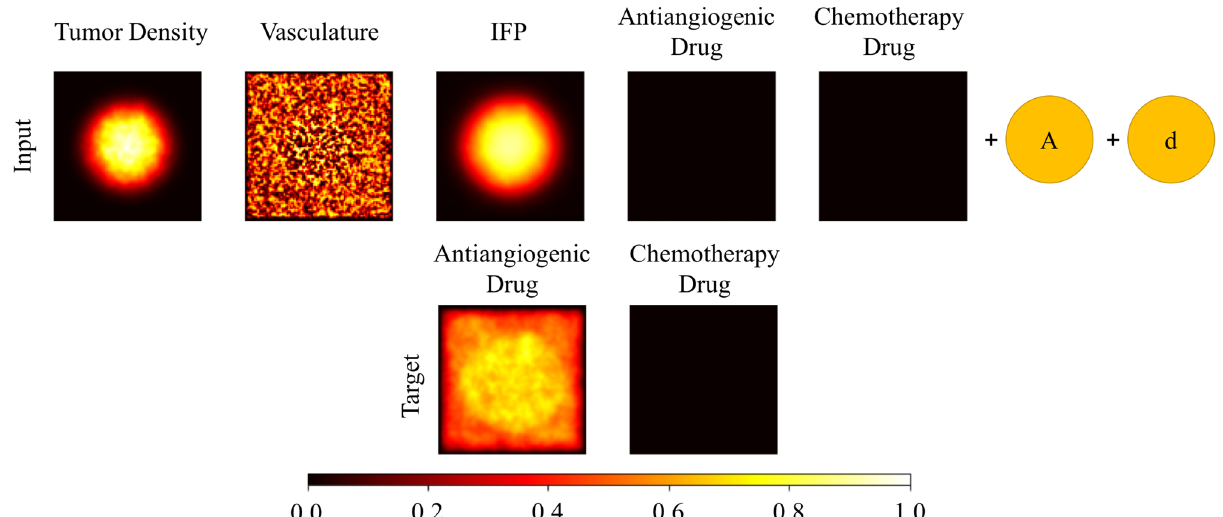
Figure 4. An example pair from the Diffuser dataset is shown. The input and target tensors are presented in first and second rows respectively. The input tensor consists of five channels which are tumor density, vasculature, IFP, antiangiogenic drug, and chemotherapy drug maps accompanied by antiangiogenic drug dosage (A) and chemotherapy drug dosage (d). The target tensor consists of two channels, the antiangiogenic drug and chemotherapy drug maps. The time interval between input and target tensor is one hour.